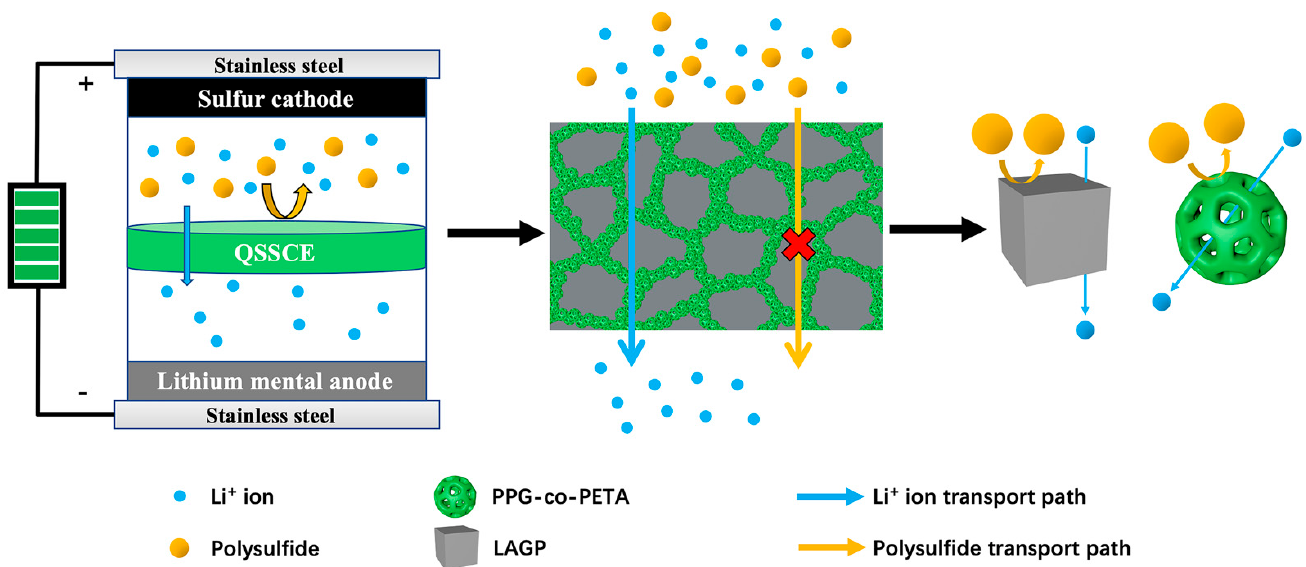
Figure 7. The mechanistic schematic drawing of the QSSCE for suppressing polysulfides’ shuttle effect in the Li-S